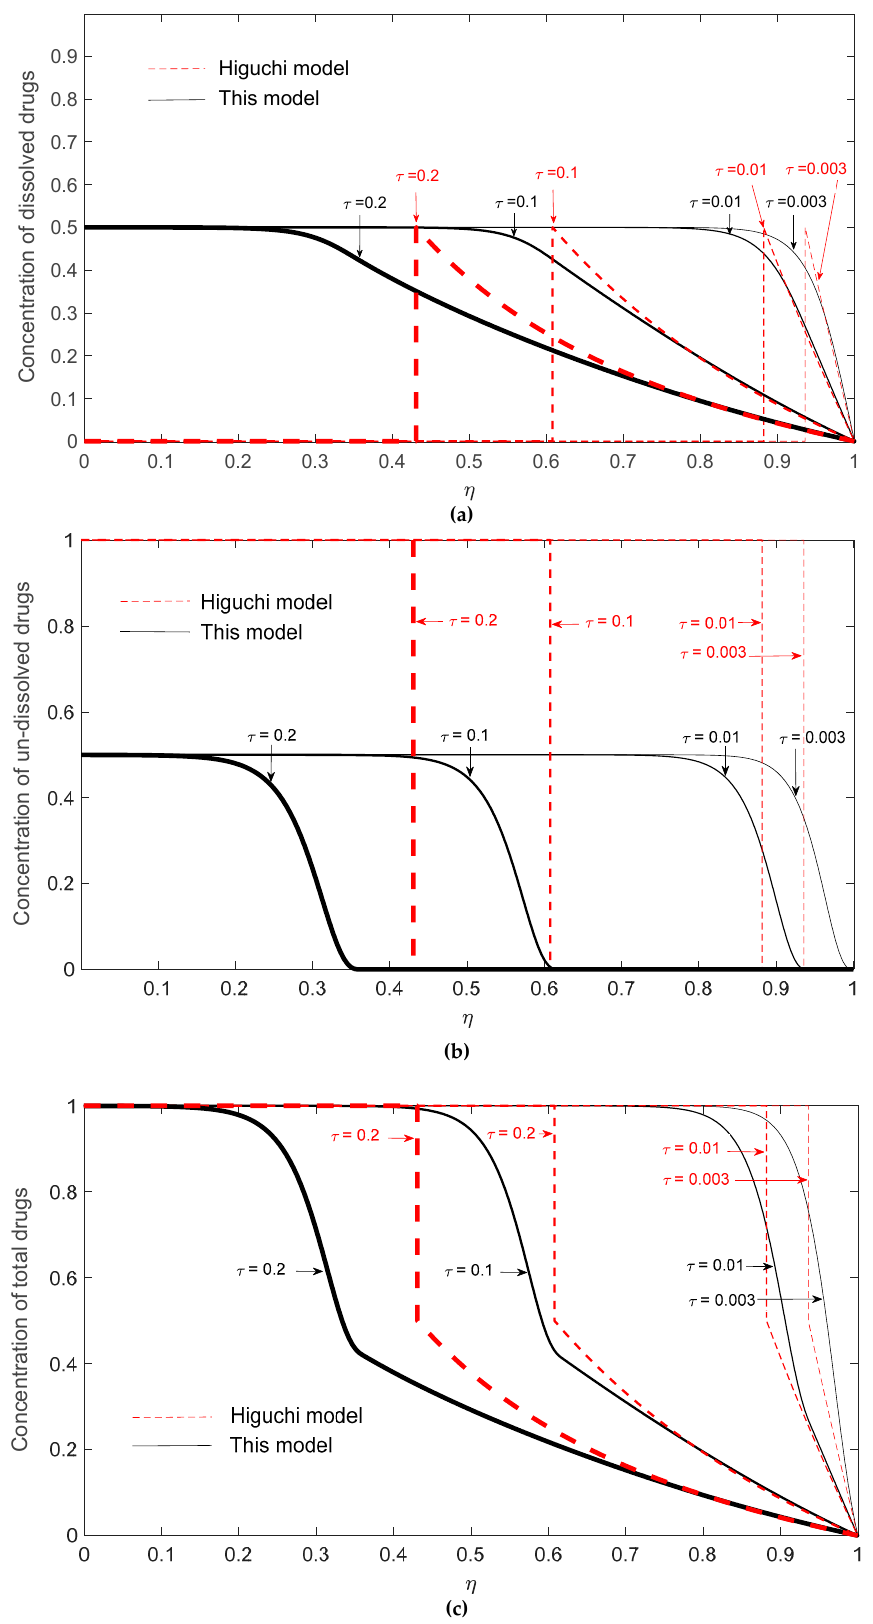
Figure 6. Radial drug concentration profiles in the matrix based on Higuchi’s model and this present model for K = 1/2 at a fixed G = 10 3 for ( a ) dissolved drugs; ( b ) un-dissolved drugs; ( c ) total drugs. Table 2. The maximum deviations between Higuchi’s model and this present model for n = 2/3 (% fraction of released drug).